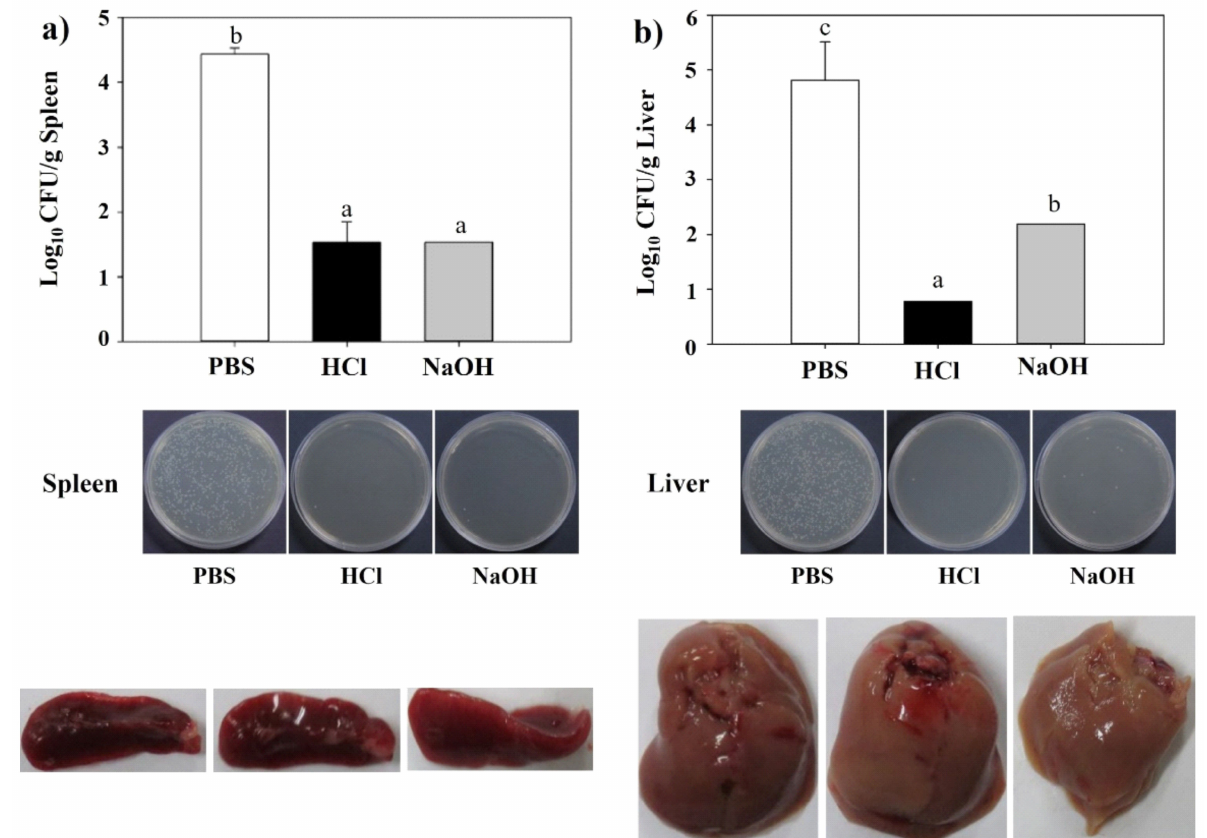
Figure 8. Bacterial loads, viable cell counts and morphological changes in spleen ( a ) and liver ( b ) homogenates after a virulent Lm challenge. All data were expressed as mean ± standard error of the mean and compared using Duncan’s multiple range tests. The letters (a–c) indicate significant differences between the bacterial burden of the immunized (HCl and NaOH) and non-immunized groups